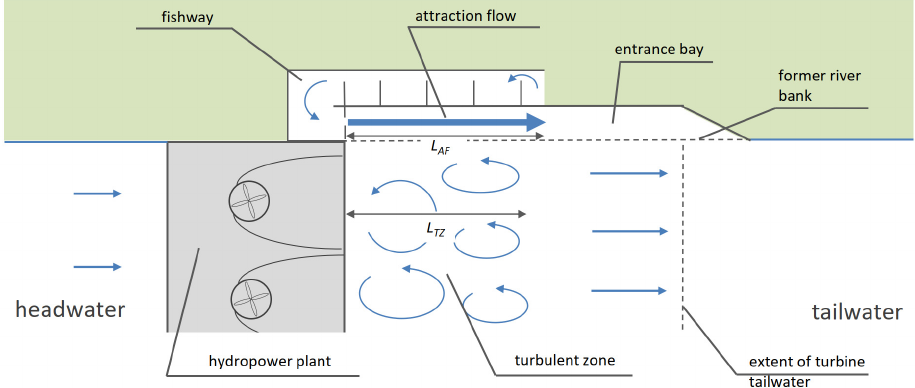
Figure 2. Scheme of fishway entrance at hydropower plant tailwater. Entrance bay and attraction flow are used to create a migration corridor where flow conditions meet hydraulic requirements such as directional flow and comparatively low turbulence; L AF = length of a coherent attraction flow jet; L TZ = length of the turbulent zone.